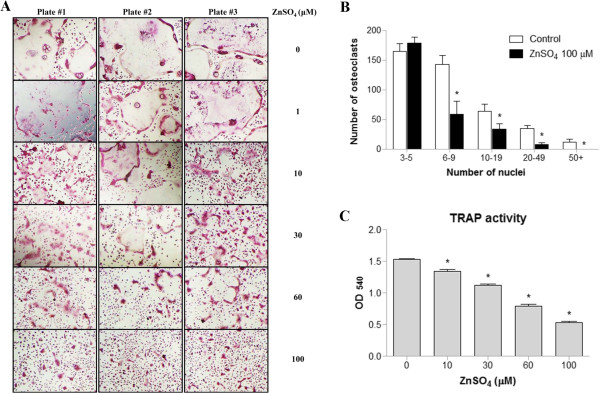
Zinc inhibits RANKL-induced osteoclast formation and fusion from BMMs. (A) BMMs were cultured for 4 days with M-CSF (30 ng/ml), RANKL (120 ng/ml), and various concentrations of ZnSO4. The cells were stained for TRAP. (B) TRAP-positive multinucleated cells (nuclei ≥ 3) were counted using manual counting and a nuclei-counter plug-in for the Image J program. (C) TRAP activity was measured at 540 nm. Data are presented as the mean ± S.D. of three independent experiments; *P < 0.05 compared to control.